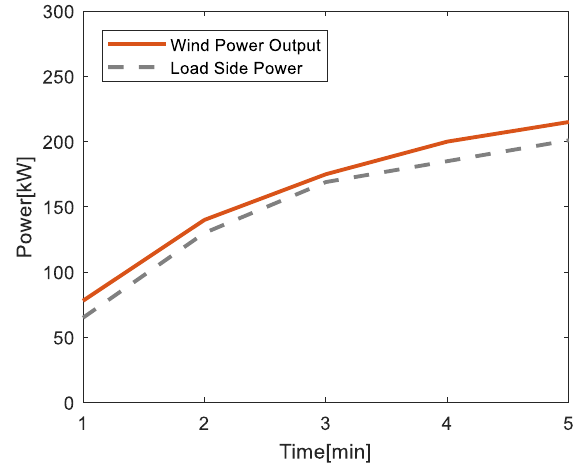
Figure 2. Wind farm power and its corresponding load conditions in period 2.